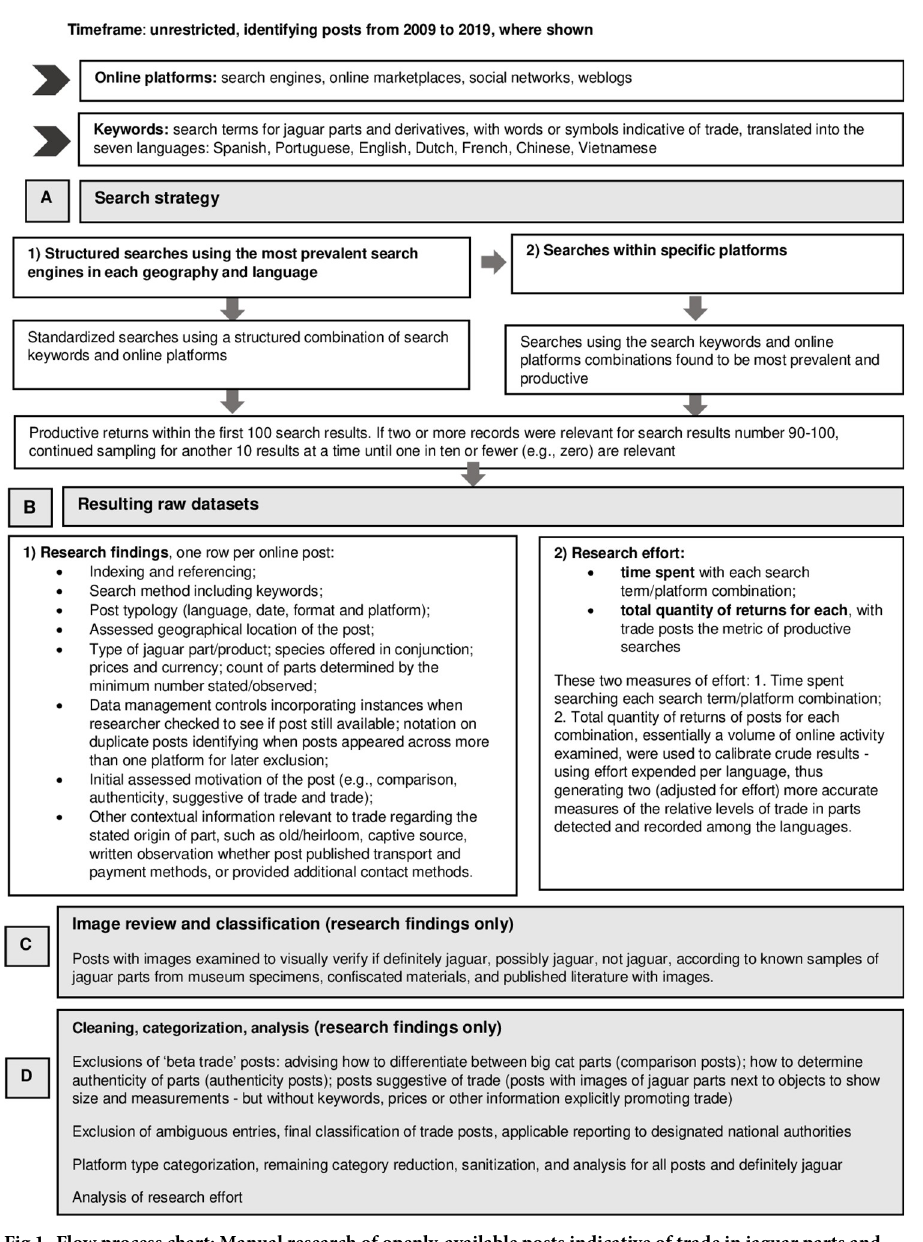
Fig 1. Flow process chart: Manual research of openly-available posts indicative of trade in jaguar parts and products.